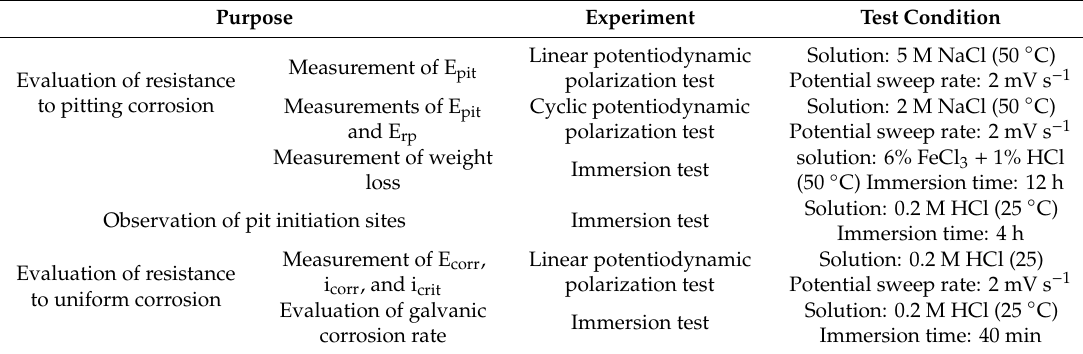
Table 2. Experimental conditions for the corrosion